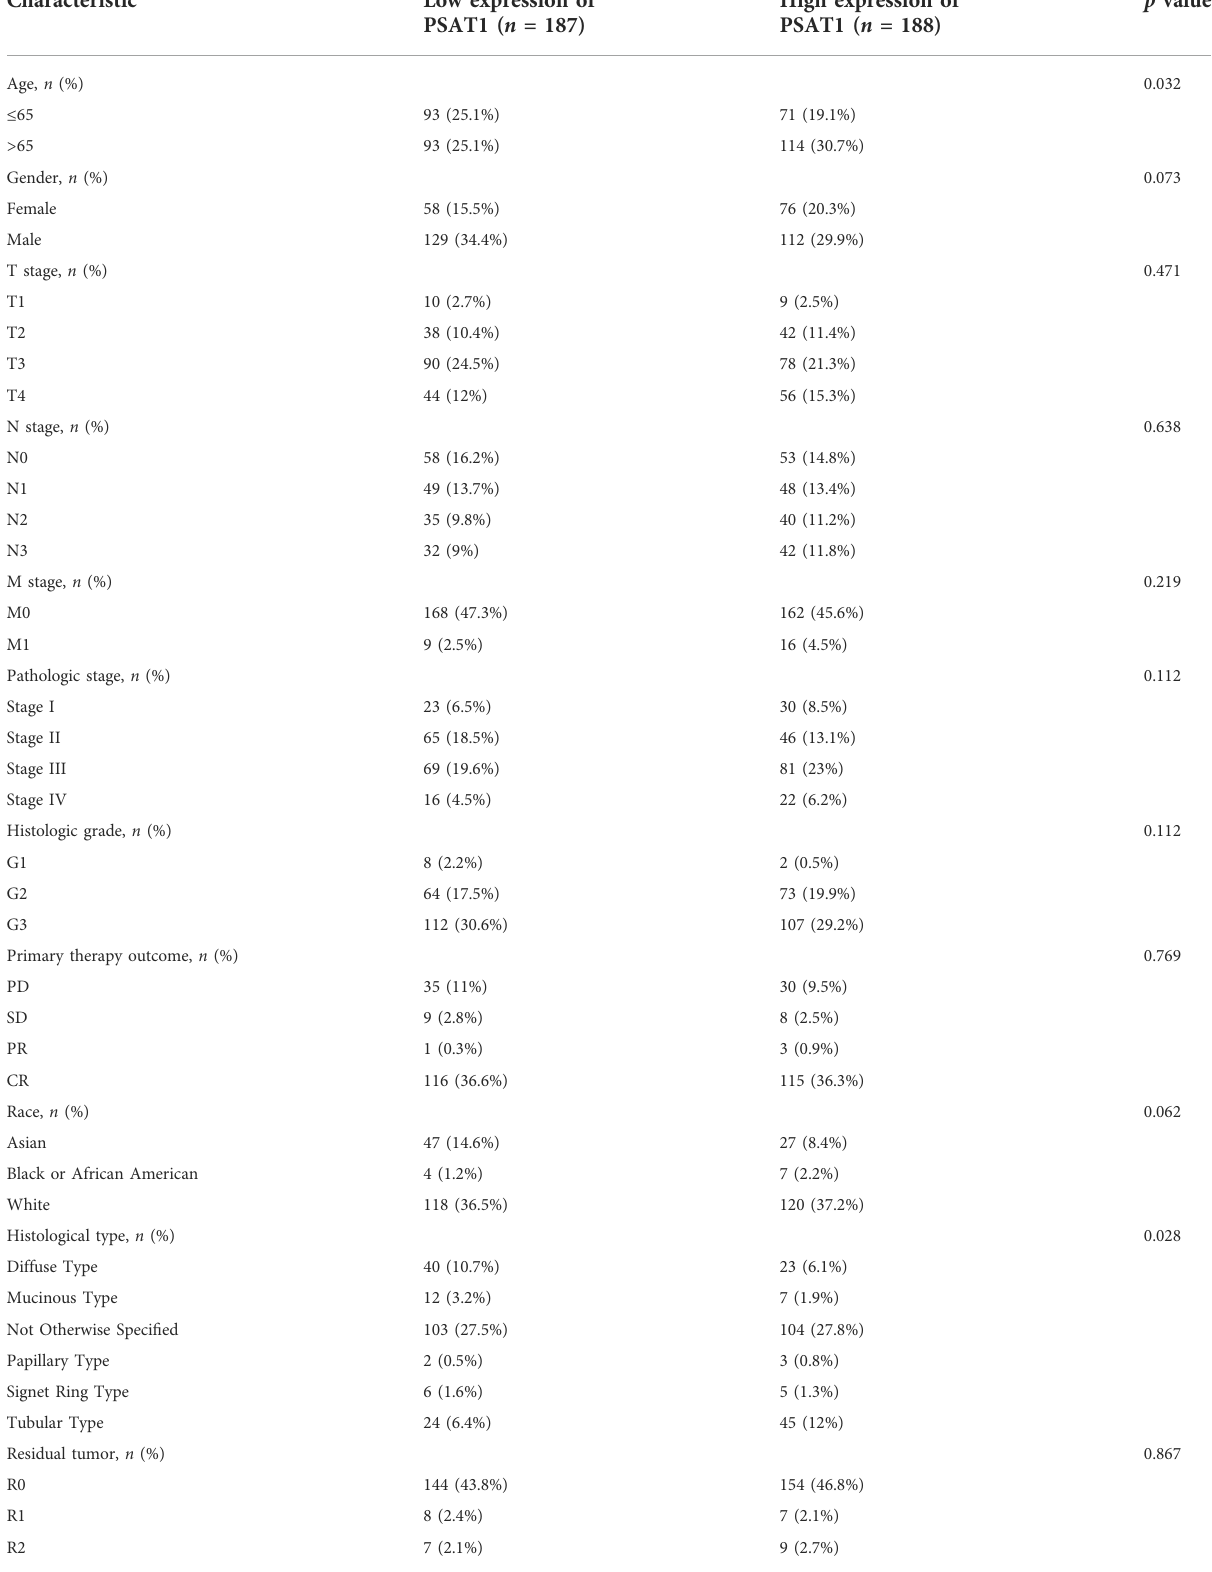
TABLE 1 Gastric cancer patients ’ demographic characteristics and PSAT1